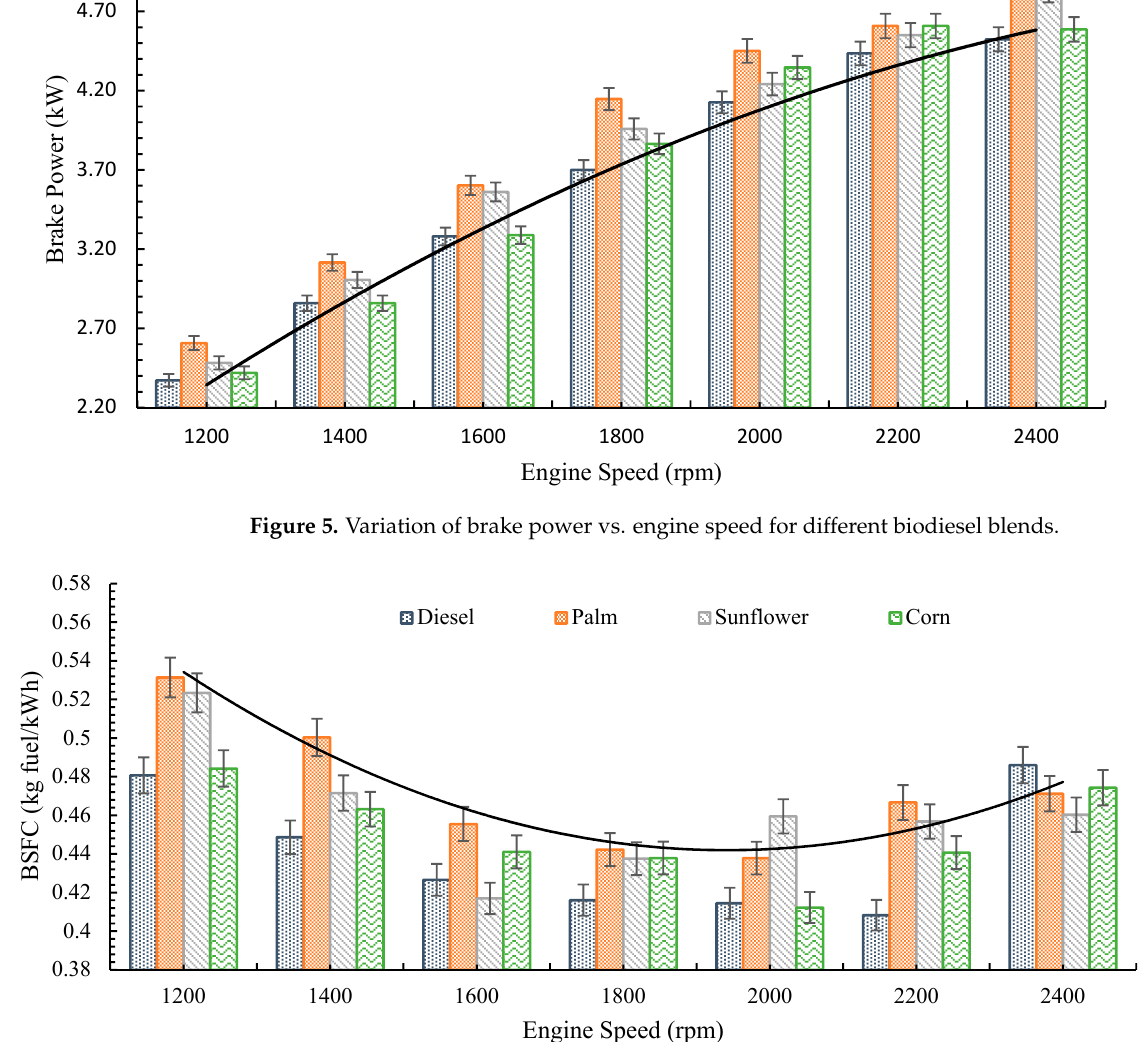
Figure 6. Variation of BSFC vs. engine speed for different biodiesel blends.